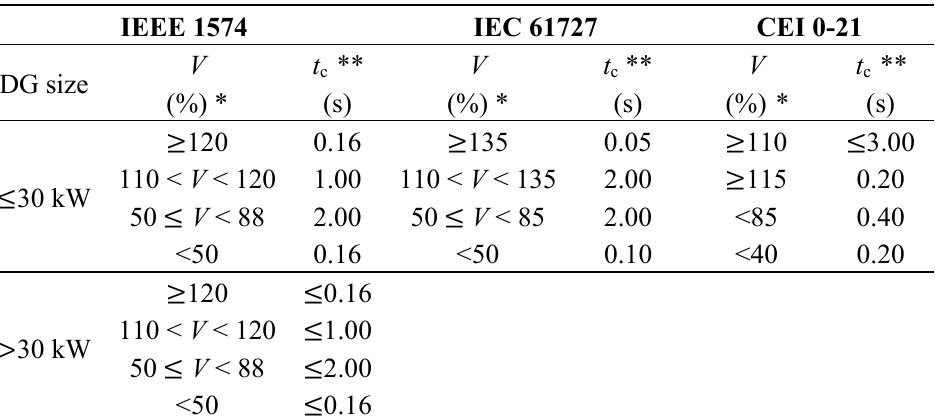
Table 1. Voltage requirements for LV distribution